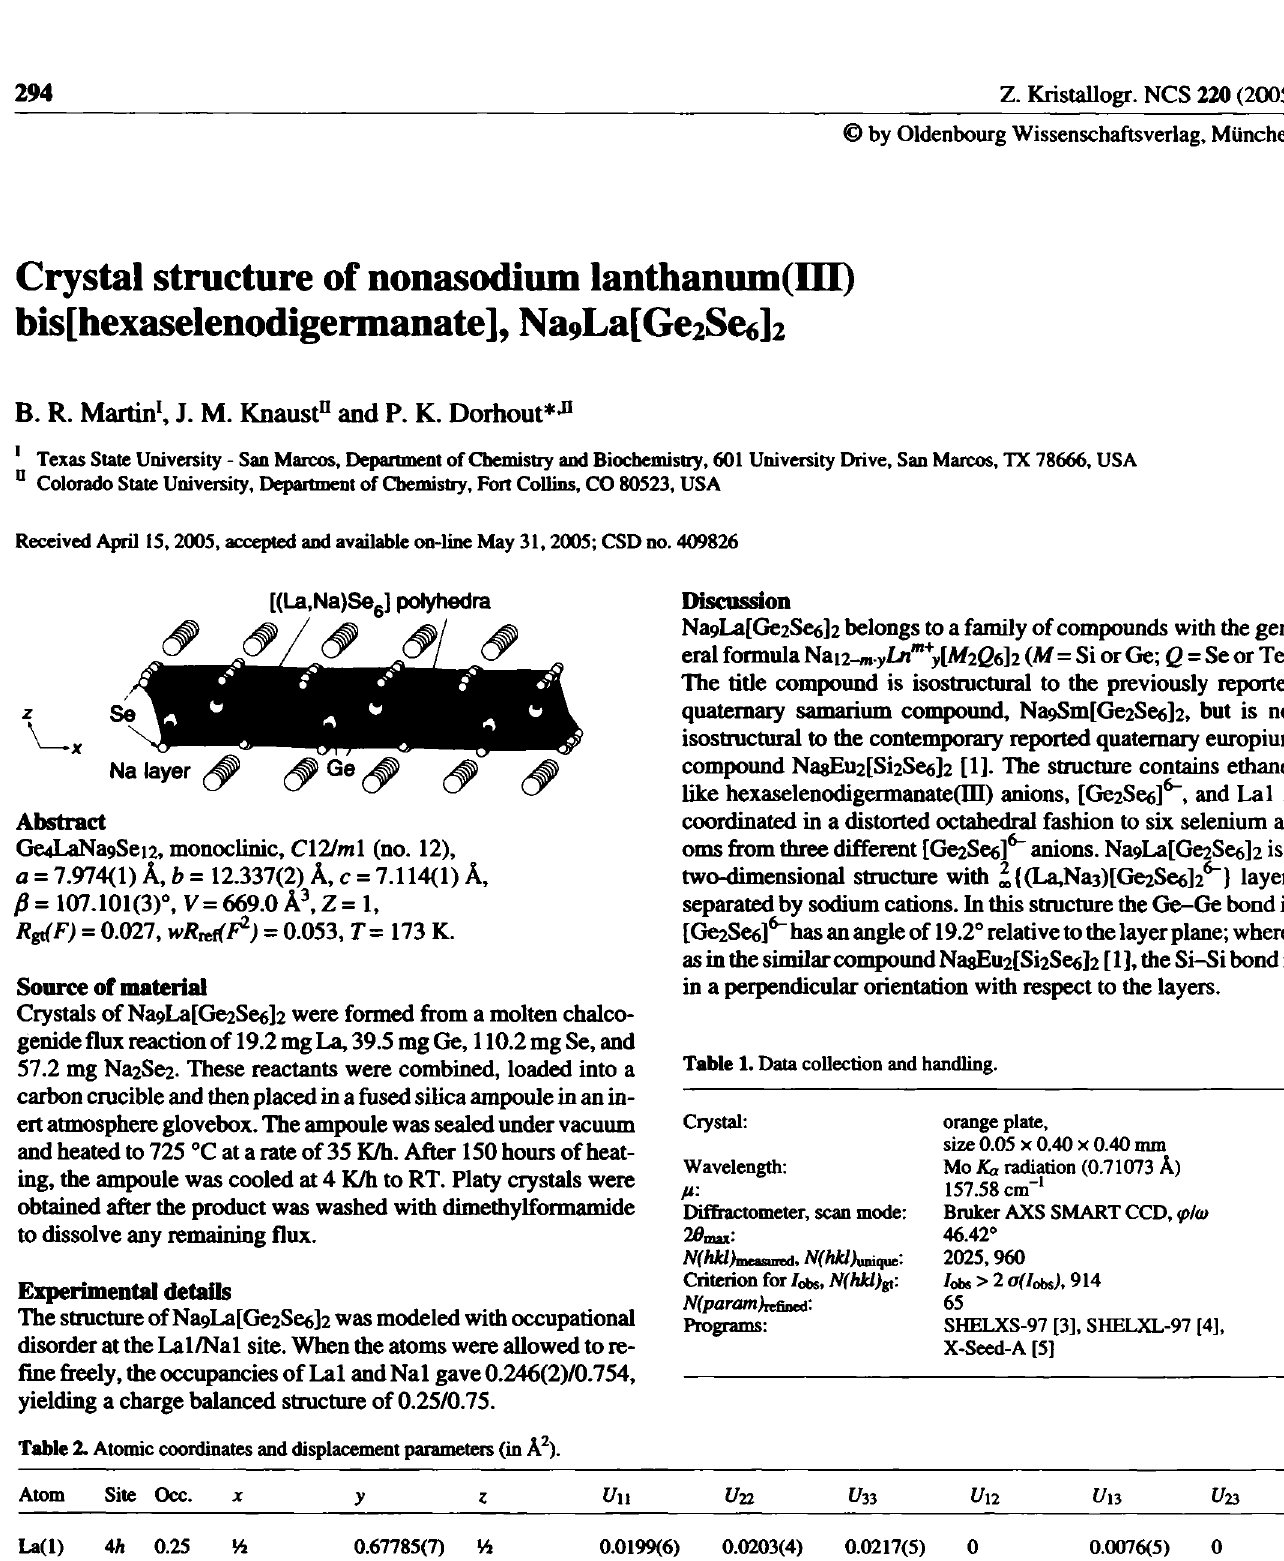
Table 2. Atomic coordinates and displacement parameters (in A 2 ).